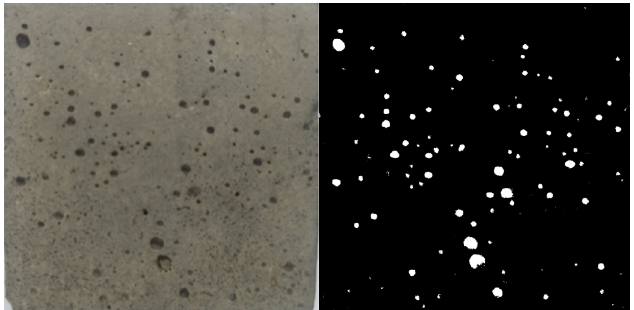
Figure 5. Original image and image thresholding.